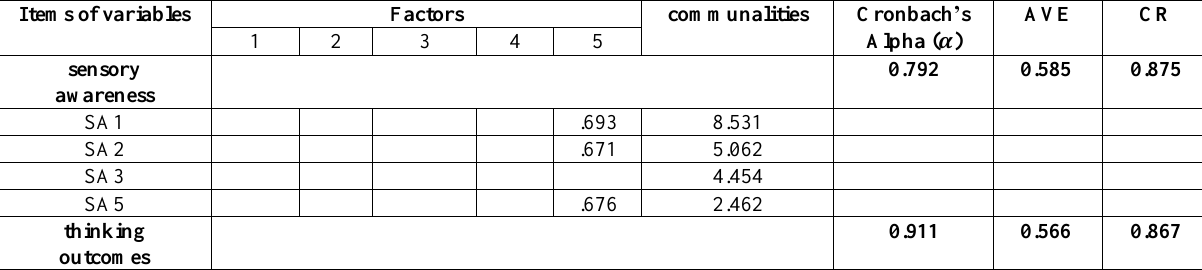
Table 3. The Factorial Structure Along with, Reliability, AVE and